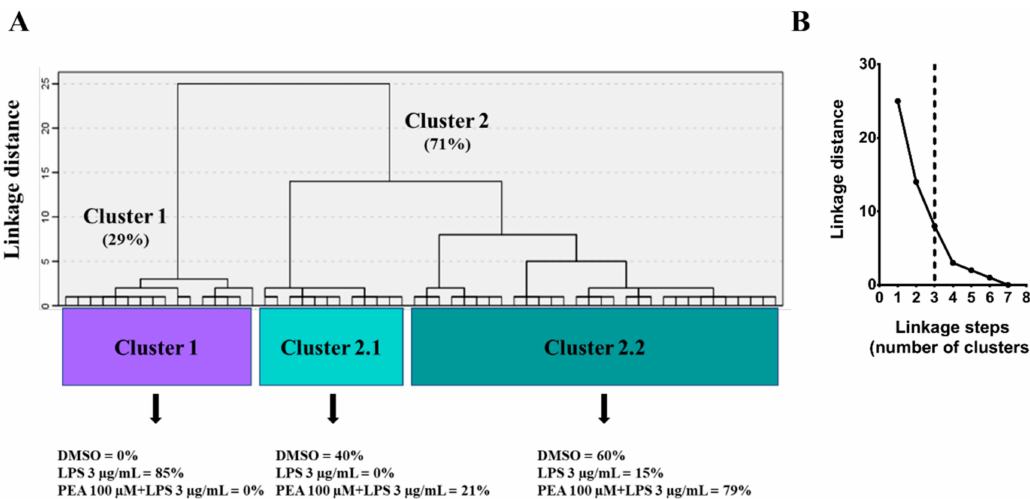
Figure 6. Classification of microglia according to FracLac parameters. ( A ) Hierarchical cluster analysis (HCA) of microglial cells, treated as described above, based on parameters calculated by FracLac analysis. Dendrogram for 59 cells, where the abscissa represents individual microglia, and the ordinate corresponds to the linkage distance measured by Euclidean distance. As shown, data were classified as two main clusters (Cluster 1 and 2). Cell morphology of LPS-treated microglia fit into Cluster 1; on the contrary, both not treated cells and cells pre-treated with PEA belong to the second Cluster (Clusters 2.1 and 2.2) ( B ) Three was identified as an appropriate number of clusters according to the linkage distance (Euclidean distance) vs linkage steps (number of clusters) analysis performed following Thorndike’s procedure, as indicated by the vertical dashed